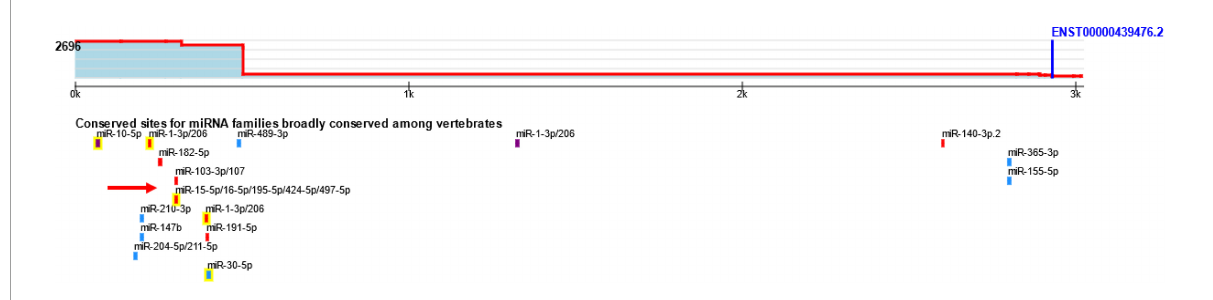
FIGURE1 The predicted binding site of miR-16 on BDNF mRNA using TargetScan.